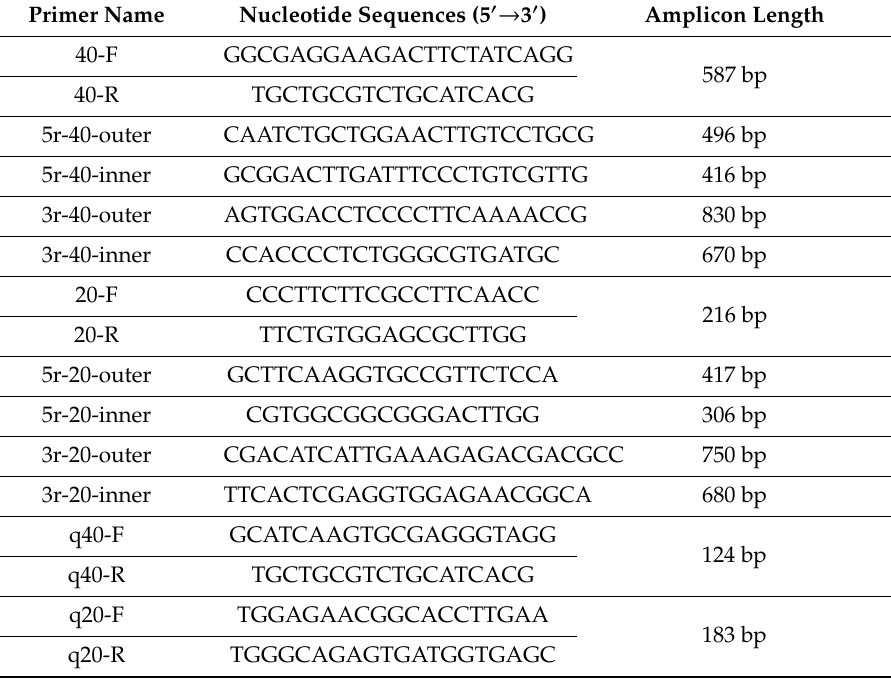
Table 1. Primers